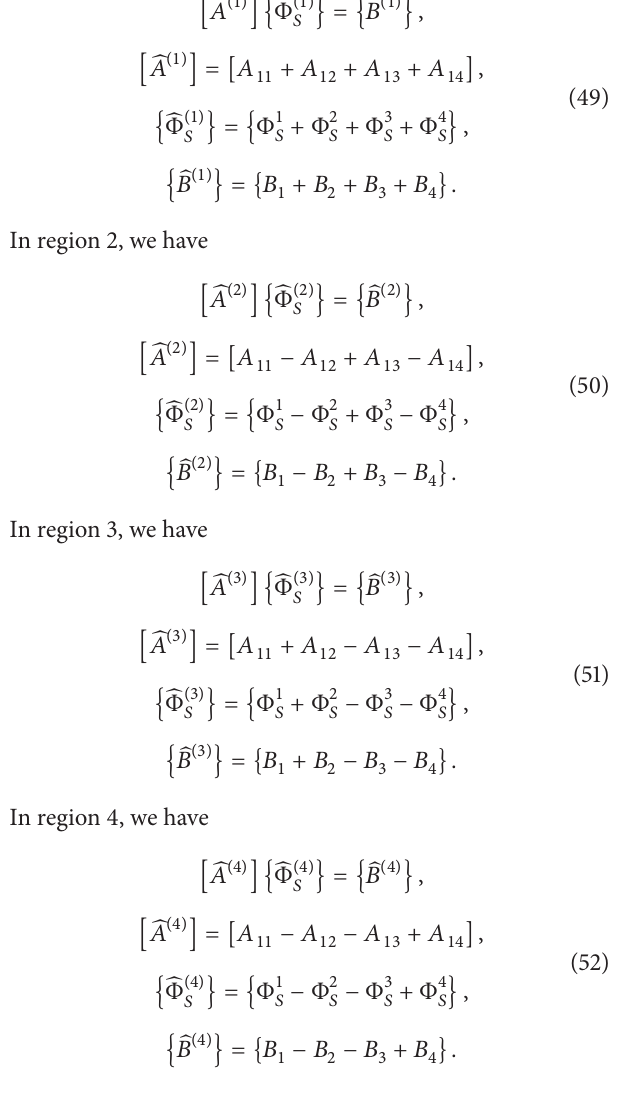
Figure 4: Sketch of the district of symmetry.